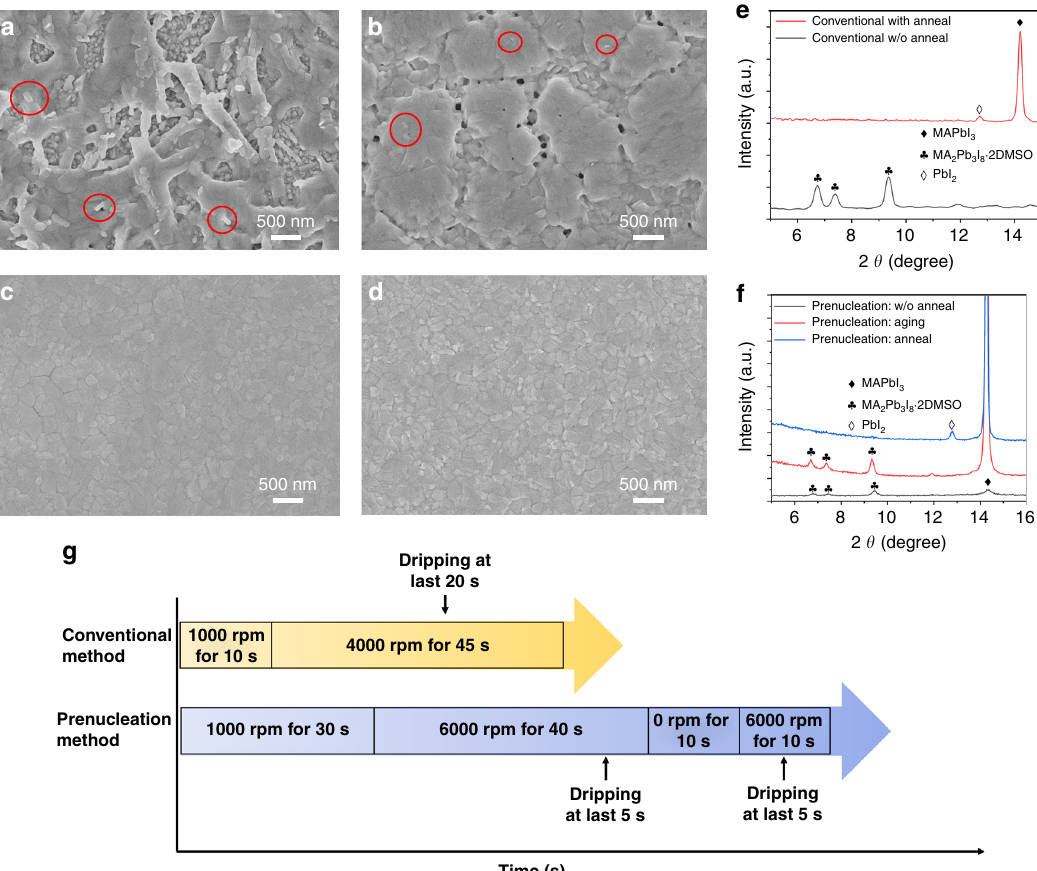
Fig. 3 The comparison between conventional and prenucleation methods. The intermediate and perovskite fi lms were synthesized by the spin coating and antisolvent dripping process in ambient atmosphere at 40% RH. The SEM images of a the intermediate fi lms without annealing and b perovskite fi lms after annealing at 98 °C for 7 min synthesized using the conventional method; the perovskite fi lm is rough and full of pin holes. The SEM images of c the intermediate/perovskite fi lms after aging, without annealing and d perovskite fi lms after annealing at 98 °C for 7 min synthesized using the prenucleation method; both of the fi lms are compact and smooth. e The XRD patterns of the conventional method synthesized intermediate (black curve) and perovskite fi lms (red curve). f The XRD patterns of prenucleation method synthesized fresh intermediate (black curve), aged intermediate (red curve) and perovskite fi lms (blue curve). g Schematic illustrating the difference between the conventional method and prenucleation methods, the latter being an exquisite programmed spinning and antisolvent dripping